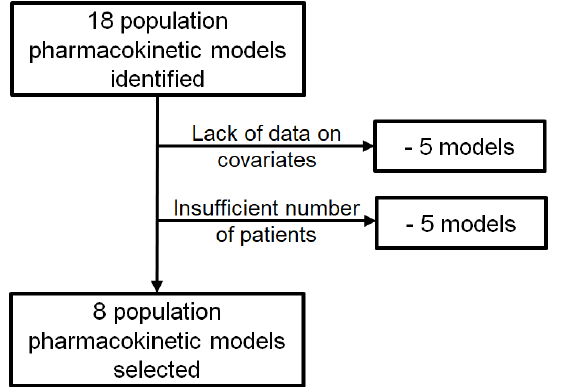
Figure 1. Flowchart of studies included in the evaluation.